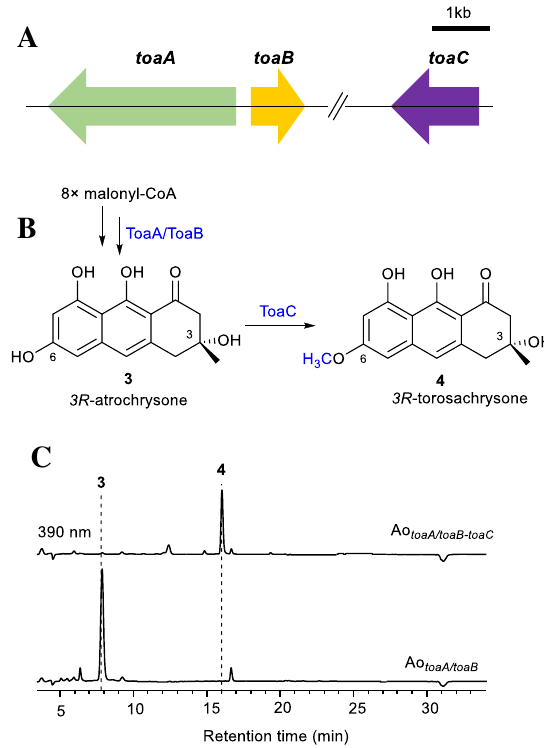
Fig. 2 Heterologous biosynthesis of tetrahydroanthracene 3R ‑atrochrysone 3 and 3R ‑torosachrysone 4 in Aspergillus oryzae. A Silent toa gene cluster and the separated methyltransferase ToaC. B Biosynthetic pathway of 3R ‑torosachrysone 4 . C Metabolite analysis of culture extracts of A. oryzae heterologous expression strains by HPLC (λ 390 =